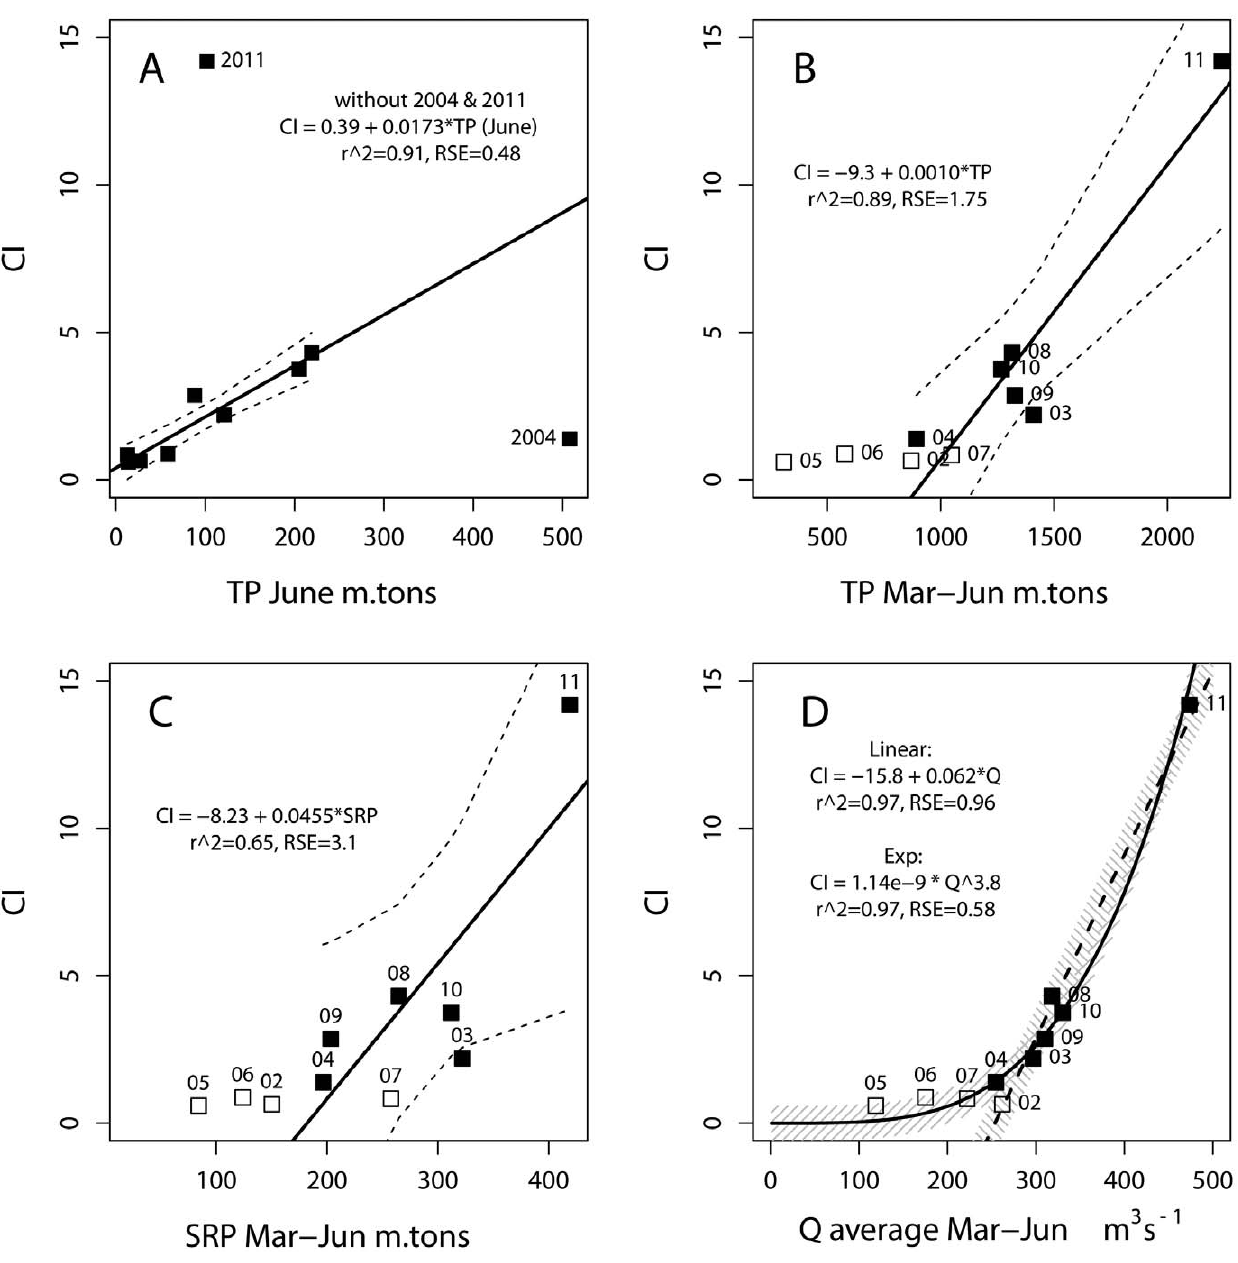
Figure 5. Bloom intensity from 2002 to 2011 compared to loads with CI of 1 equivalent to 300 km 2 of 10 5 cells mL 2 1 (A) TP for June, with regression for eight years excluding 2004 and 2011; (B) cumulative TP for March to June with regression (and regression confidence interval) for bloom years (filled squares); (C) cumulative SRP for March to June like (B) with regression line and confidence for bloom years; (D) average Q for March to June, with linear and exponential regression for bloom years. Shading in (d) indicates the RSE for each of the two regressions, which closely matches the regression confidence (except near 2011).